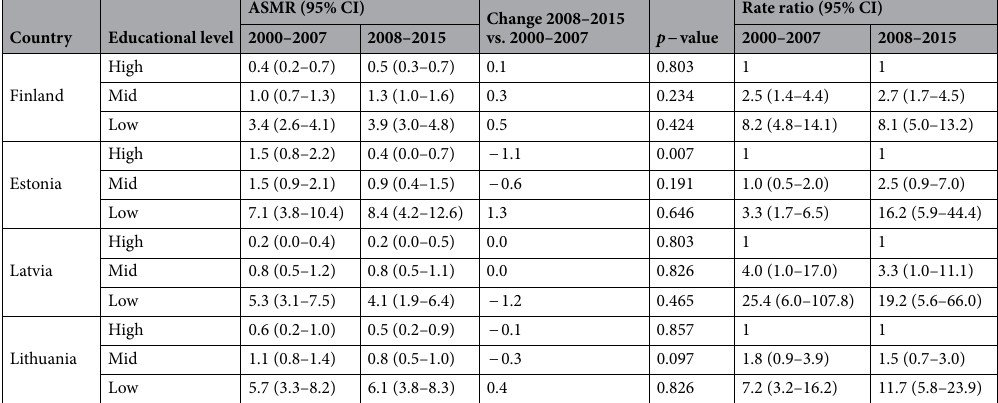
Table 3. Age-standardised mortality rates per 100,000 person years and mortality rate ratios by educational level for epilepsy in 2000–2015 among women in the 30–74 age group. ASMR age-standardised mortality rate per 100,000 person years, CI confidence